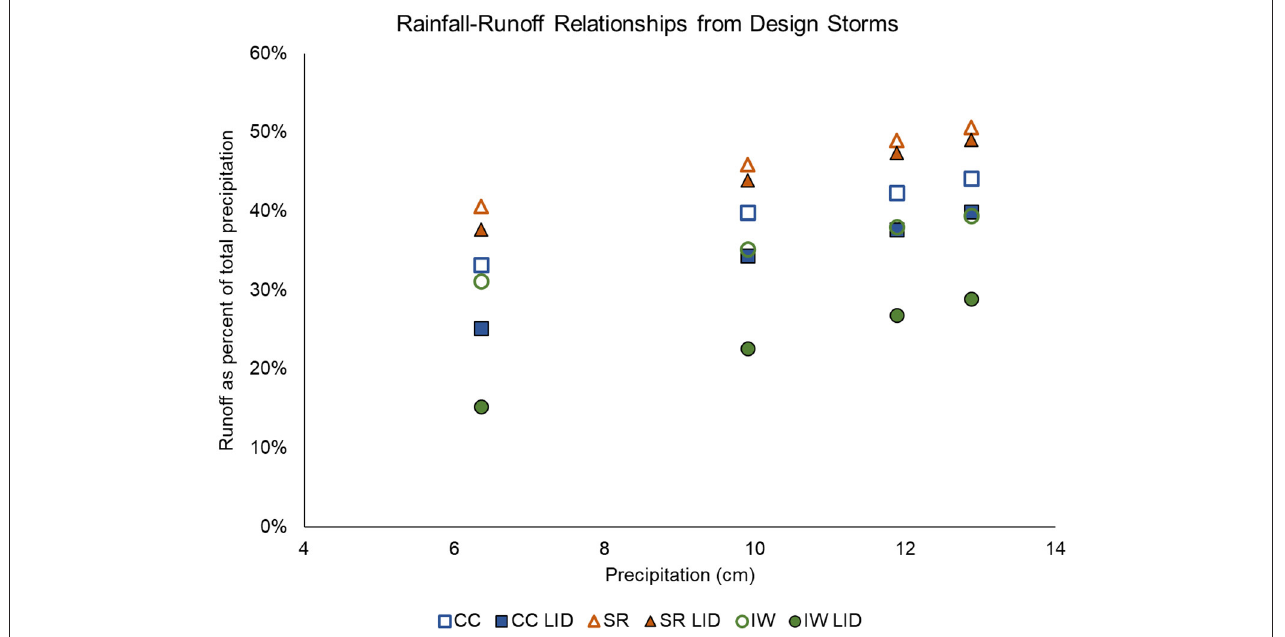
FIGURE 3 | Rainfall-runoff relationships from the design storms; included here are results from simulations for the 2-year storm (6.4cm), 25-year storm (9.9cm), 25-year storm + 20% (11.9cm), and 25-year storm + 30% (12.9cm). Solid symbols are for the scenarios with LID incorporated, open symbols are for scenarios without LID features. Symbols used are circles for the IW future results, squares for the CC results, and triangles for the SR results. Note that in all cases, the IW future has the lowest proportion of rainfall as runoff, whereas the SR future has the highest runoff ratio. The addition of constructed LID features decreases runoff for the IW and CC